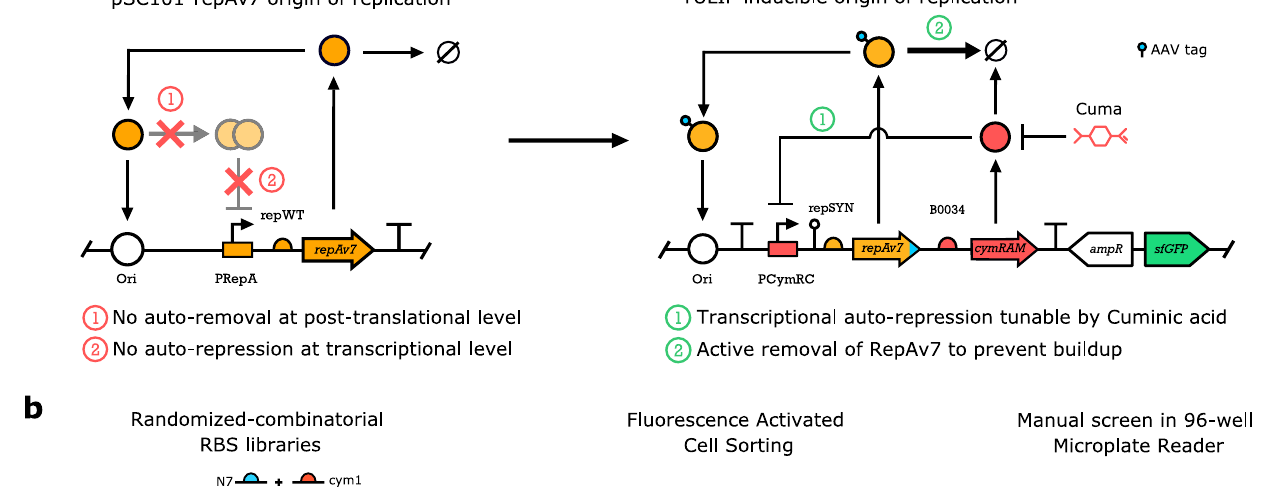
manual screening with microplate reader. c TULIP was characterized in detail in NEBStable. PCN (measured via qPCR) and gene expression (measured via fl ow cytometry) show a strong linear relationship. Experiments in a microplate reader reveal that varying PCN via Cuminic acid has negligible impact on growth rate (gray). Cuminic acid induction levels are 0.4, 0.8, 1.2, 1.6, 2.0, 2.4, 3.0, 4.0, and 5.0 μ